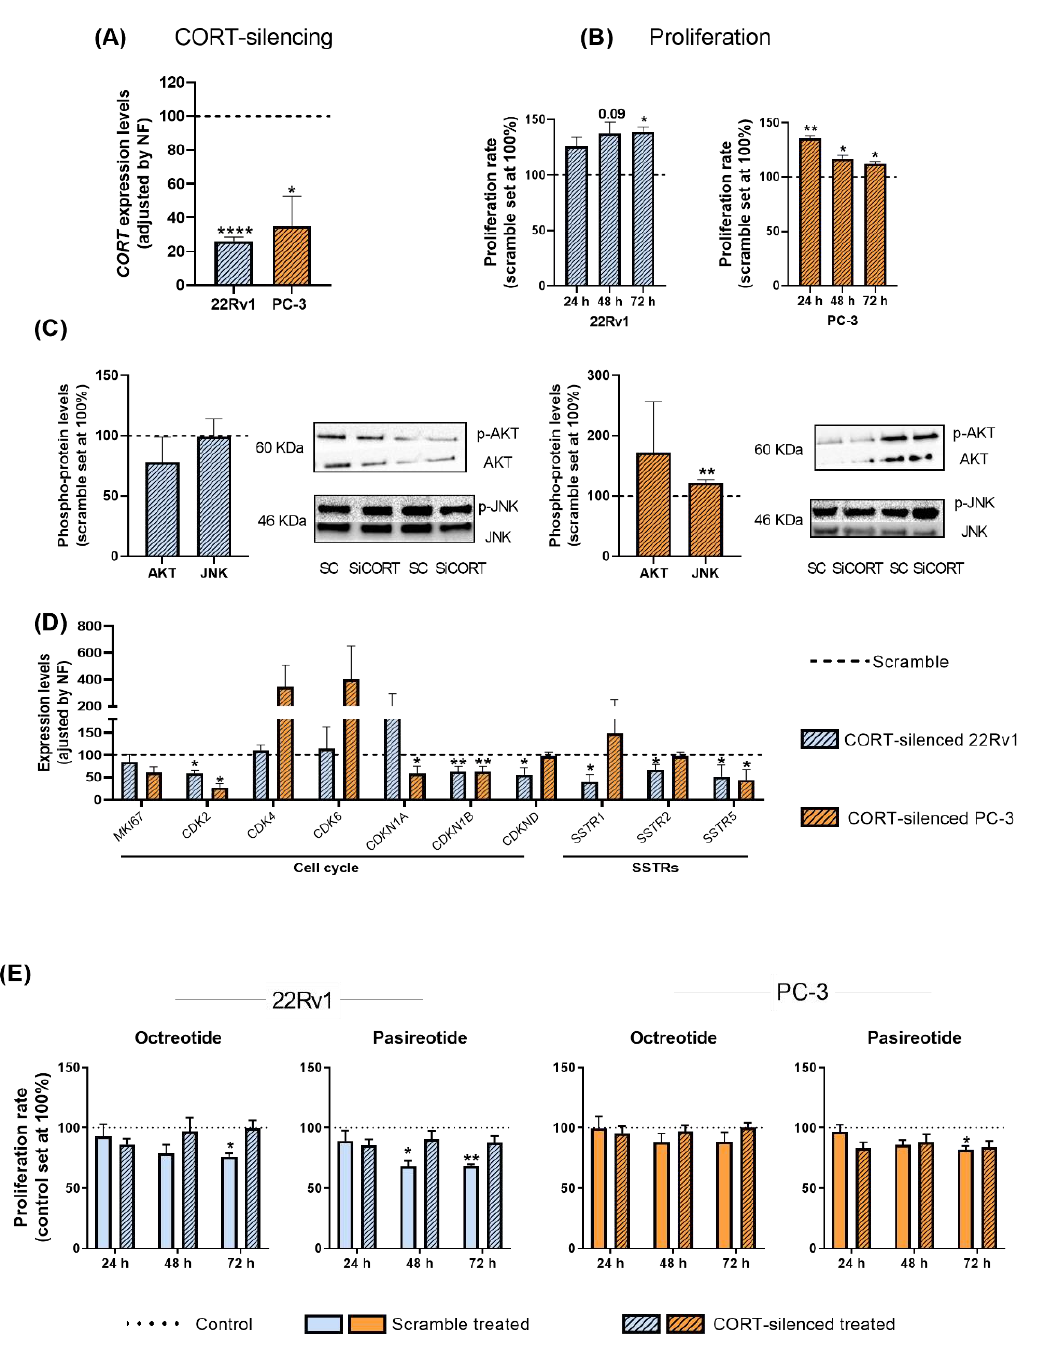
Figure 5. Functional and pharmacological consequences of cortistatin (CORT)-silencing in androgen-independent (AI) prostate cancer (PCa) cells. ( A ) Validation of CORT-silencing in 22Rv1 and PC-3 cells. ( B ) Proliferation rate in response to CORT-silencing in AI-PCa cells. Data were represented as percent of scrambled cells (set at 100%). ( C ) Phosphorylation levels of protein belonging to different oncogenic signaling pathways (AKT, JNK) in response to CORT-silencing in AI-PCa cells. ( D ) Expression of proliferation/cell-cycle and somatostatin receptors genes in response to CORT-silencing in AI-PCa cells. Data were represented as percent of scrambled cells (set at 100%). ( E ) Proliferation rate of scrambled AI-PCa cells or CORT-silenced AI-PCa in response to octreotide and pasireotide. Data were represented as the percent of vehicle-treated cells (set at 100%). Asterisks (* p < 0.05; ** p < 0.01; **** p < 0.0001) indicate statistically significant differences between groups. SC: Scramble. SiCORT: small interference RNA